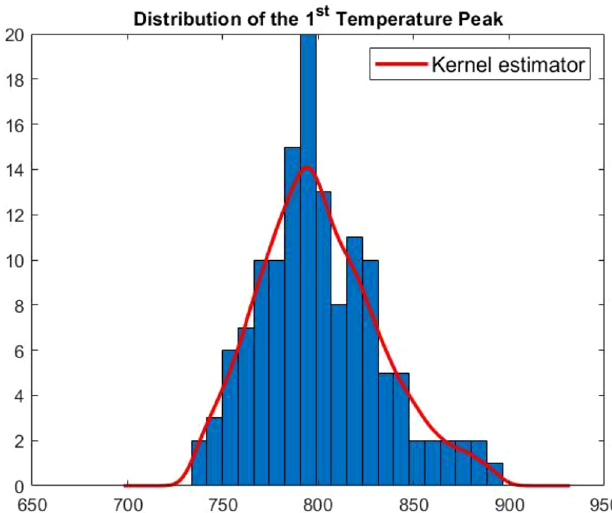
Fig. 7. Distribution of the 1 rt temperature peak.